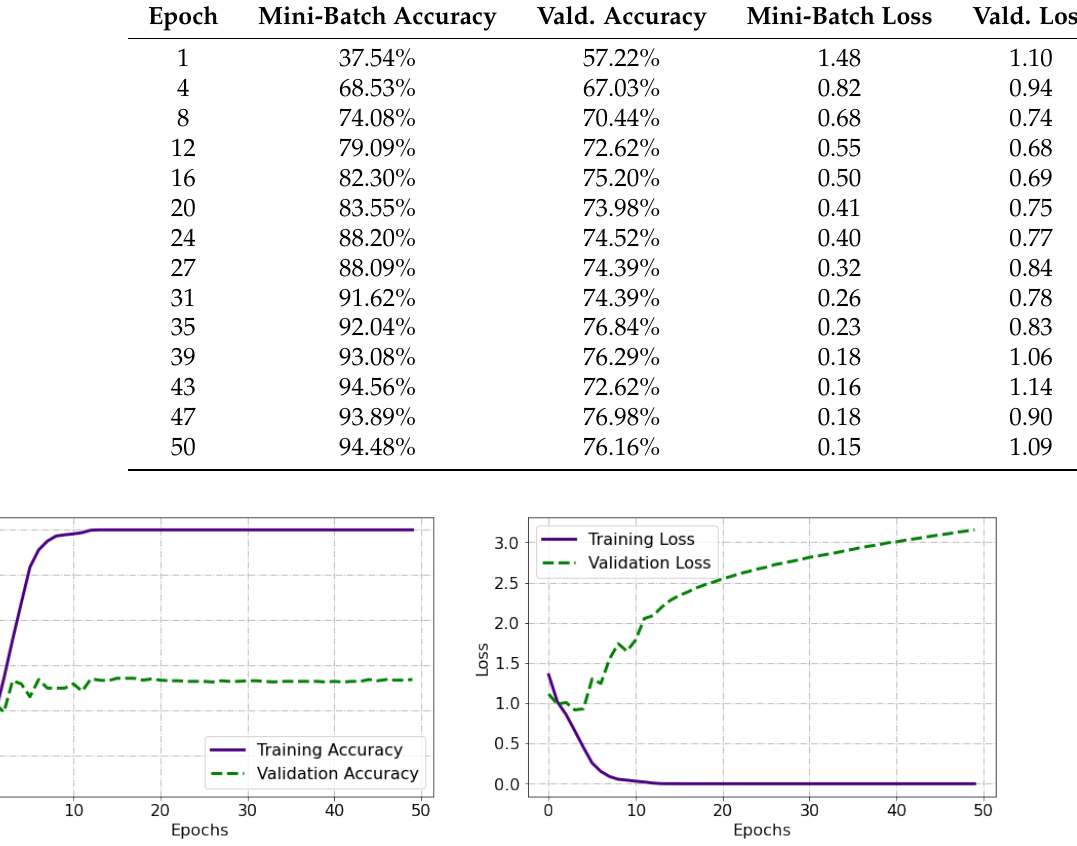
Table 2. Network training on 512-core Volta GPU result summary.